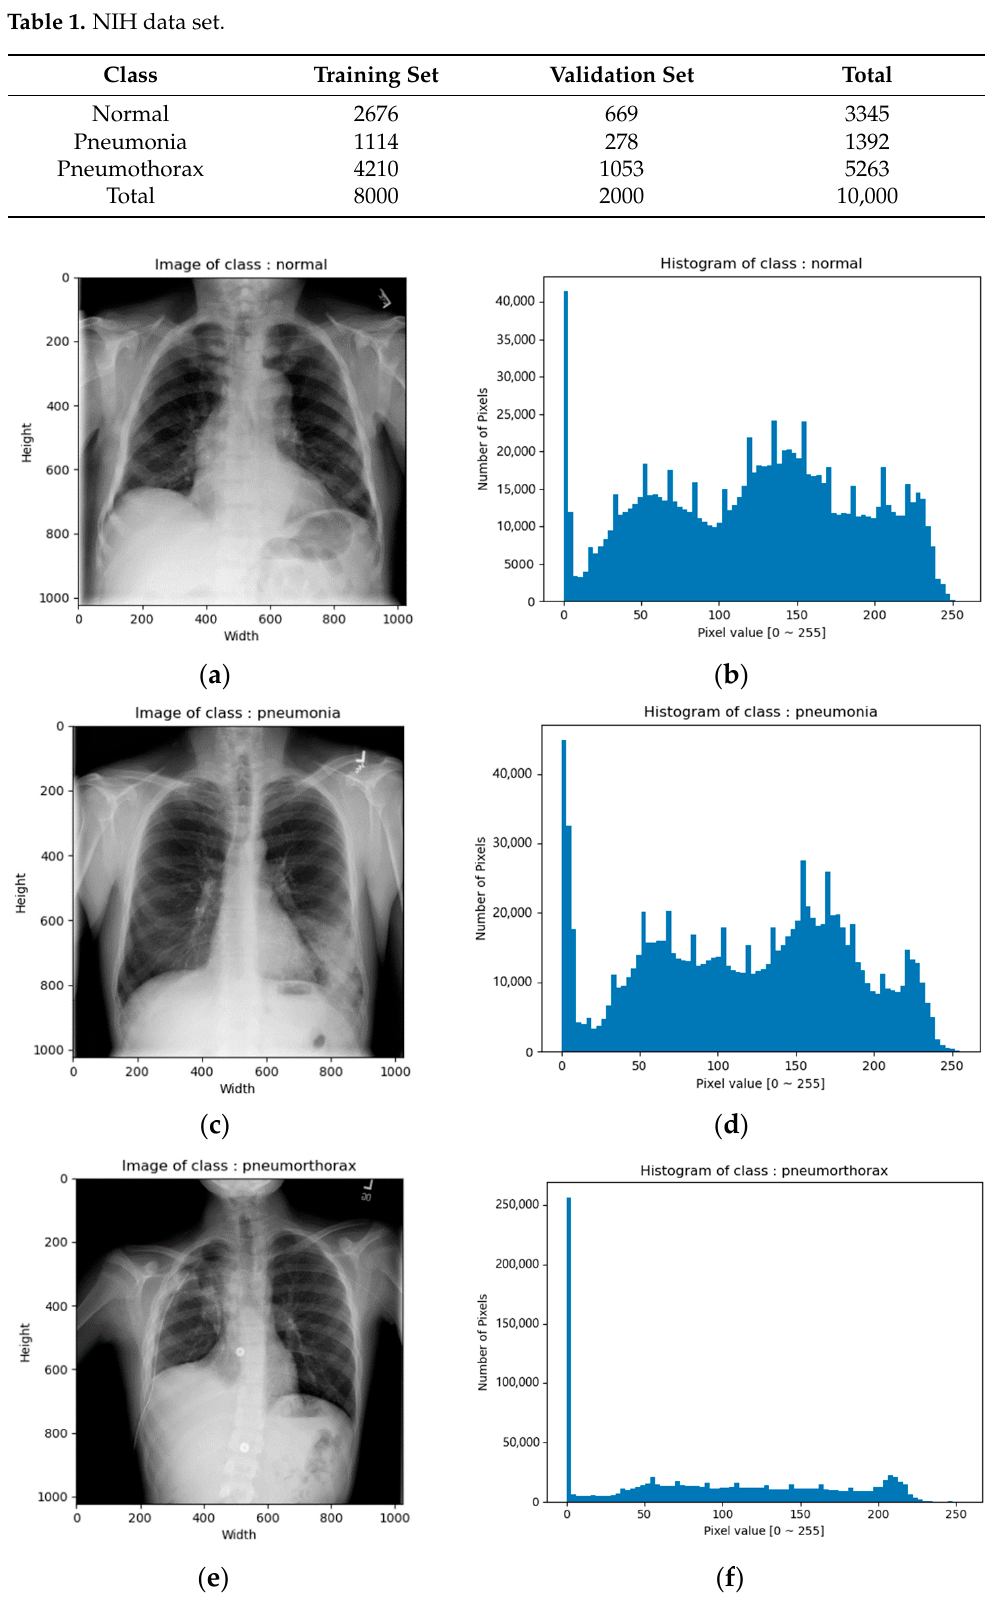
Table 1. NIH data set.